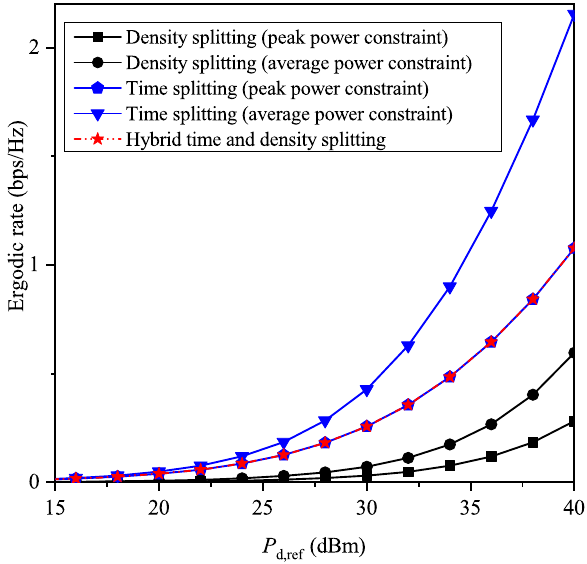
Figure 4. Maximized ergordic rate versus P d,ref for β =